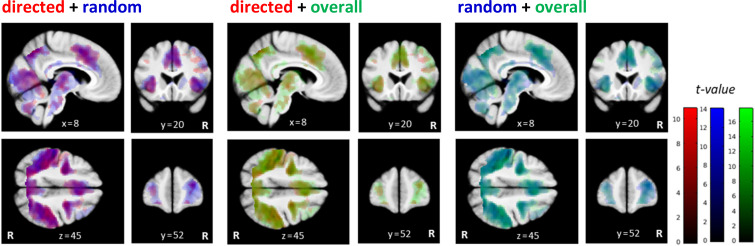
Brain activation patterns for different types of explorations .Shown are pairwise overlays of the statistical parametric maps for the contrasts explore > exploit (‘overall’ in green), directed > exploit (‘directed’ in red), and random > exploit (‘random’ in blue) over all drug conditions. While the first contrast is based on a binary choice classification according to which all choices not following the highest expected value are explorations, the other two contrast are based on a trinary choice classification, which further subdivides explorations into choices following the highest exploration bonus (directed) and choices not following the highest exploration bonus (random). All activation maps thresholded at p<0.05, uncorrected for display purposes. R: right.